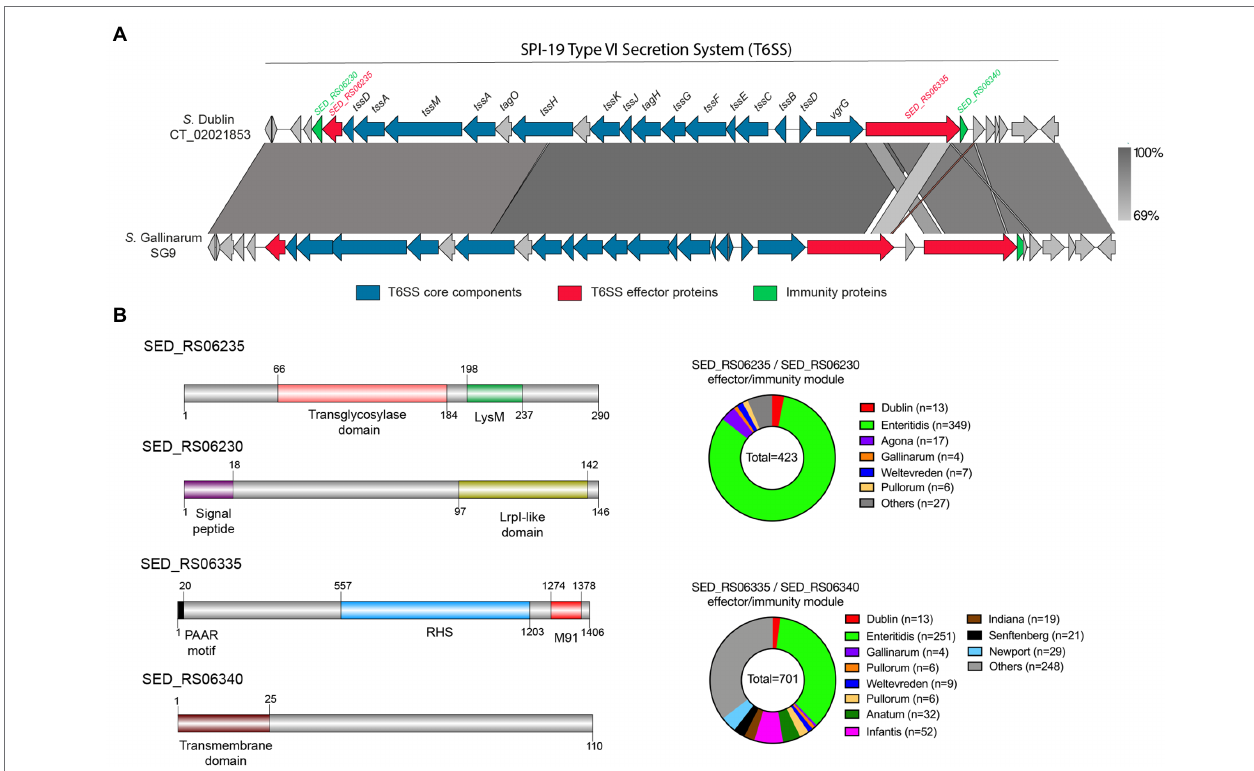
FIGURE 3 | The SPI-19 T6SS gene cluster encodes novel putative T6SS effector proteins. (A) Comparative genomic analysis of the SPI-19 T6SS cluster of S. Dublin CT_02021853 and S. Gallinarum SG9. BLASTn sequence alignment was performed and visualized using EasyFig (Sullivan et al., 2011). (B) Schematic representation and distribution among Salmonella genomes of each novel effector and immunity protein identified. Names of genes encoding novel effectors and immunity proteins are highlighted in red and green, respectively. Homologs for each component were identified by BLASTn analyses as described in Materials and